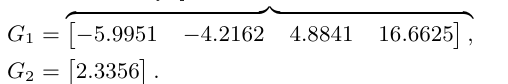
Figure 15: Identified model DSR 8 (Eq. 18) simulated 8 over the identification set. This figure shows simulation from 500 to 850 samples in Fig. 14.